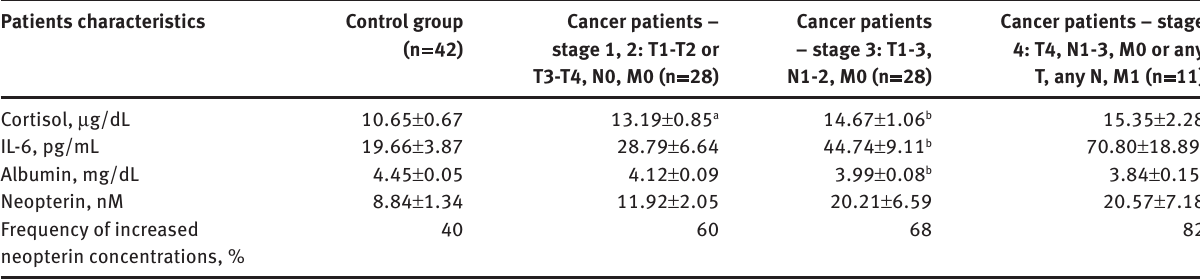
Table 1: Assignment of 67 patients with gastrointestinal cancer according to AJCC Cancer Staging-TNM classification after surgical